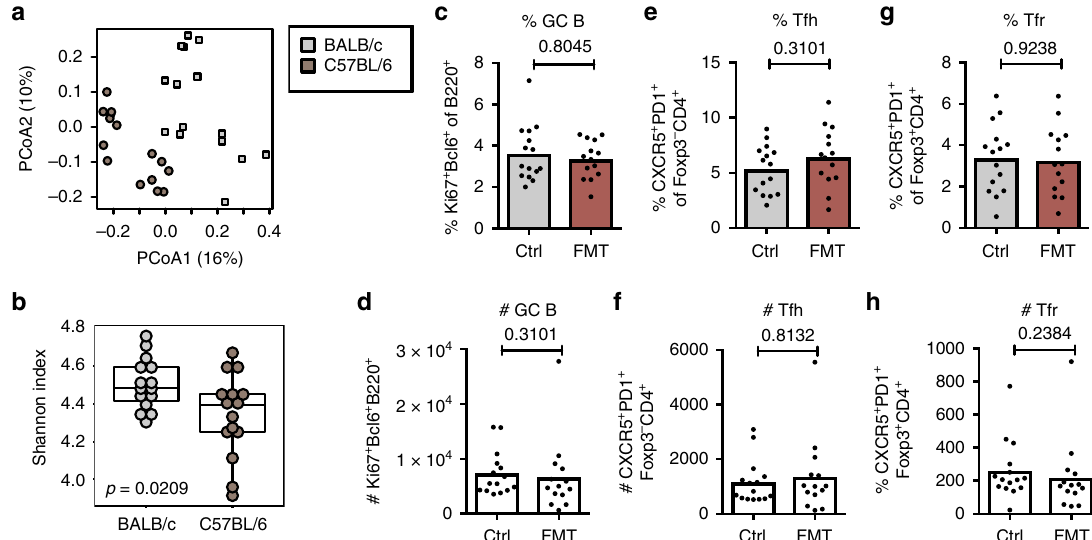
Fig. 7 Faecal microbiota transplantation between adult mice of different strains does not affect gut germinal centres. a , b 16S rRNA sequencing data generated from faecal pellets collected from adult 3-month-old C57BL/6 and BALB/c mice. ( a ) Bray-Curtis PCoA comparing samples from 3-month-old BALB/c and C57BL/6 mice. b Shannon diversities, with a p -value based on ANOVA tests. c – h Three-month-old C57BL/6 mice were given a suspension of faecal pellets taken from 3-month-old BALB/c mice by oral gavage to achieve faecal microbiota transplantation (FMT). In addition, the cages of C57BL/6 recipients were supplemented with fresh faecal pellets and dirty bedding from BALB/c mice once a week. Control mice were gavaged with PBS. The percentage and number of B220 + Ki67 + Bcl6 + GC B cells ( c , d ), CD4 + Foxp3 - CXCR5 + PD-1 + Tfh cells ( e , f ) and CD4 + Foxp3 + CXCR5 + PD-1 + Tfr cells ( g , h ) in Peyer ’ s patches as quanti fi ed by fl ow cytometry. Bar plots show the combined results of two experiments with a total of n = 14 – 15 mice per group. Bar height corresponds to the mean, each circle represents one biological replicate. P -values were determined using the Mann-Whitney test in GraphPad Prism6. Source data are provided as a Source Data fi